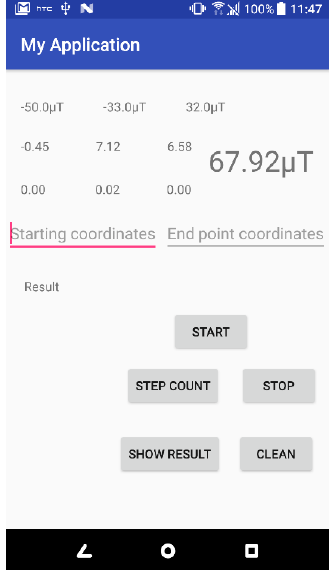
Figure 8. Magnetic field value recording interface.